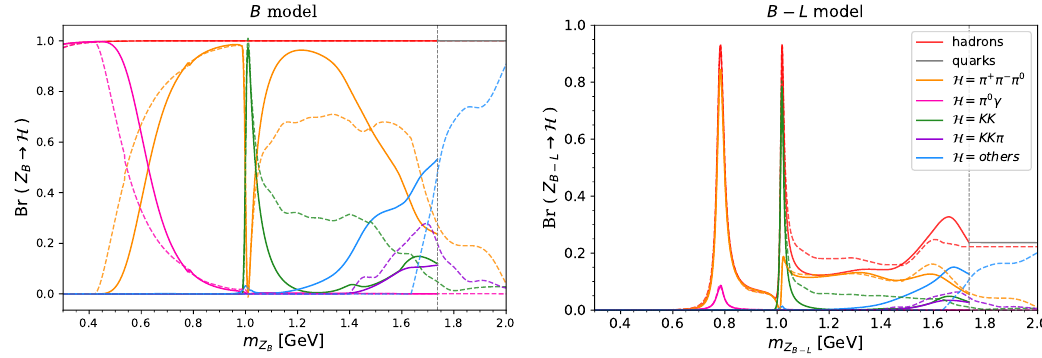
Figure 7 . Comparison of the individual contributions to the total hadronic branching ratio between our calculations (solid lines) and DarkCast (dashed lines) for the B (left panel) and B − L (right panel) models. The individual branching ratios for the other B -coupled models behave in a similar way to the B − L model. The vertical dashed gray line indicates the transition from non-perturbative to perturbative calculations as described in the